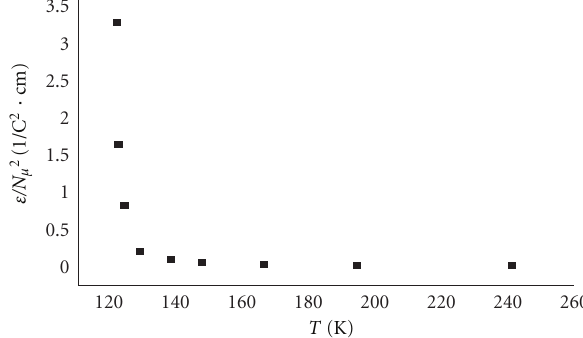
Figure 2: The dielectric constant ε calculated from (6) with the Curie constant C (7) as a function of temperature at zero pressure in the paraelectric phase ( T > T C ) for KDP.